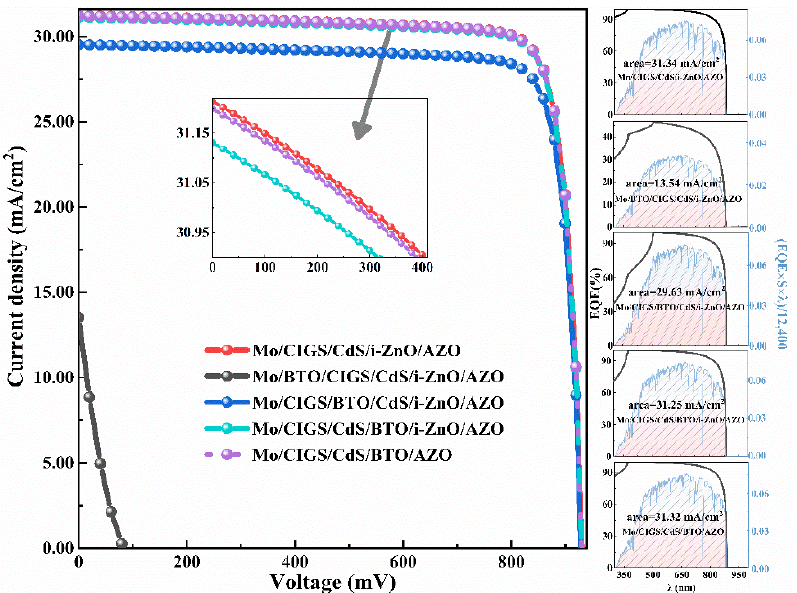
Figure 13. The J - V , corresponding EQE, and the integrated EQE curves for the different devices with the highest simulated PCE.